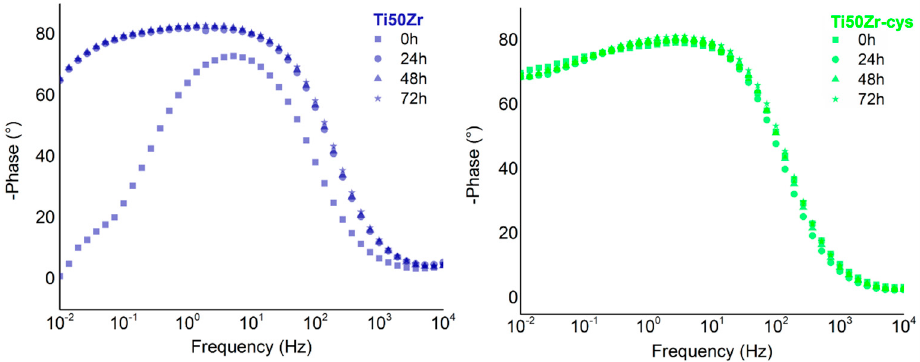
Figure 4. Bode phase plots in time for Ti50Zr substrate and coated samples.